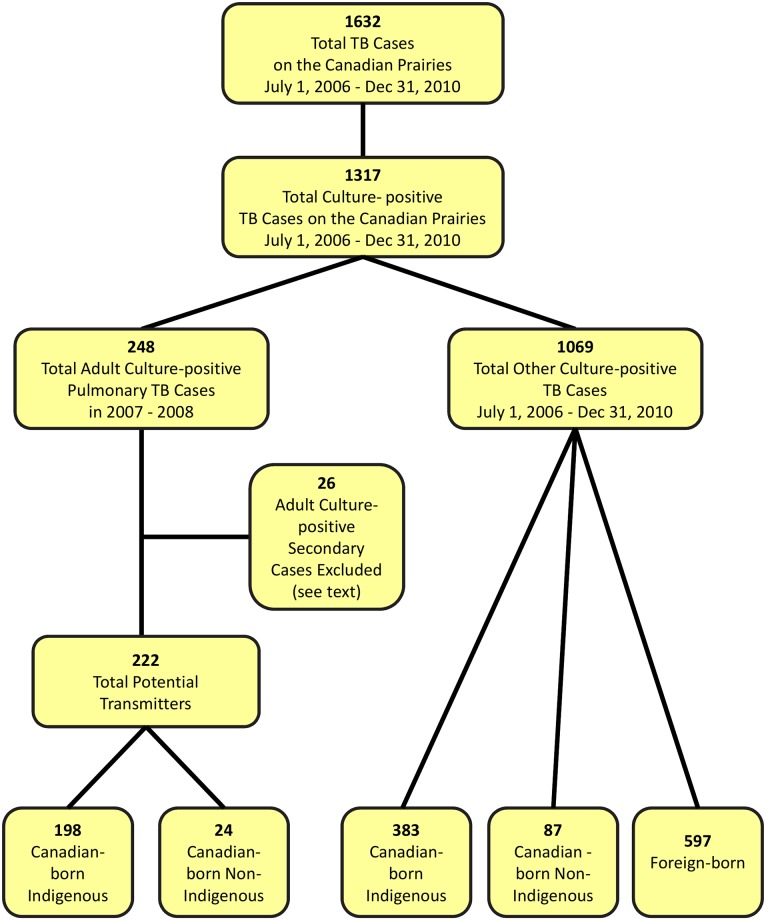
Tuberculosis cases in the prairie provinces of Canada between July 1, 2006 and December 31, 2010.Population group information was missing for two of the 1069 “other” culture-positive cases; of the 26 cases meeting the original study inclusion criteria and designated a secondary case, 25 were Indigenous and 1 was non-Indigenous.